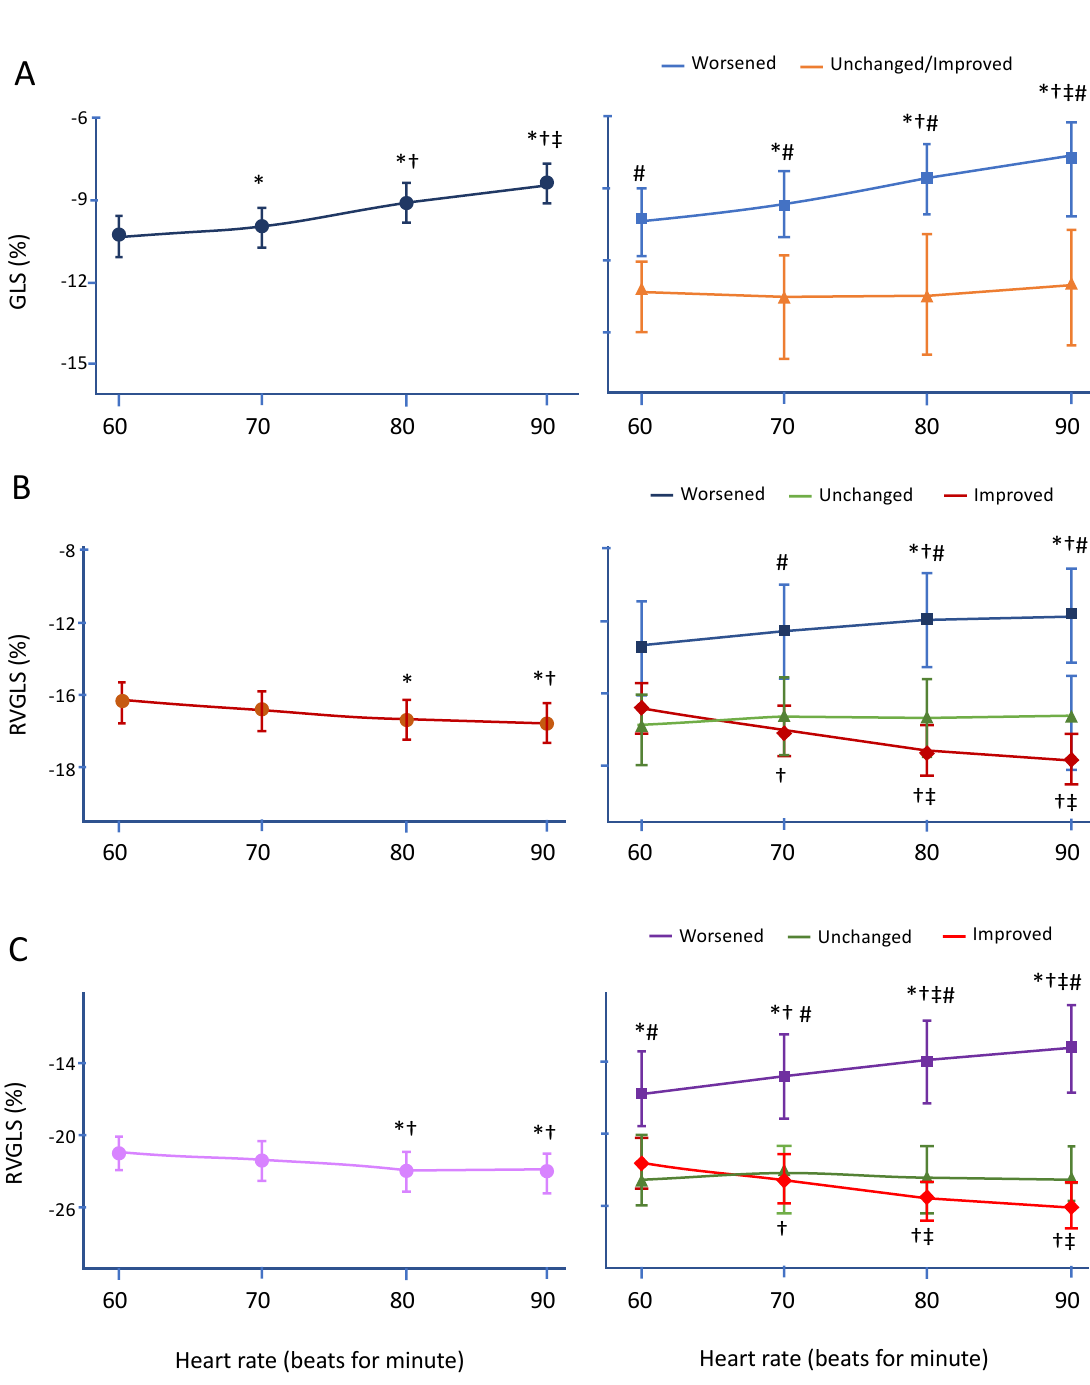
Figure 1. LVGLS ( A ), RVGLS ( B ), RVfwGLS ( C ) determined for all study participants (left) and in participants who demonstrated improvement, deterioration, or whose conditions remained un- changed (right); * p < 0.05 vs. HR of 60 beats/min; † p < 0.05 vs. HR of 70 beats/min; ‡ p < 0.05 vs. HR of 80 beats/min; # p < 0.05 vs. all other patients (as shown in the right panel ( A ) or panel ( C ),